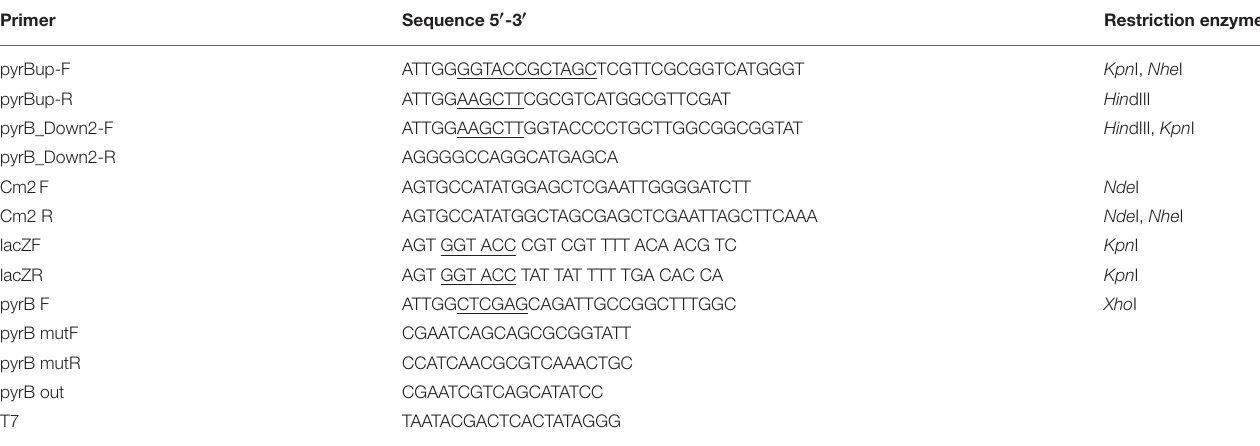
TABLE 2 | List of primers used in this